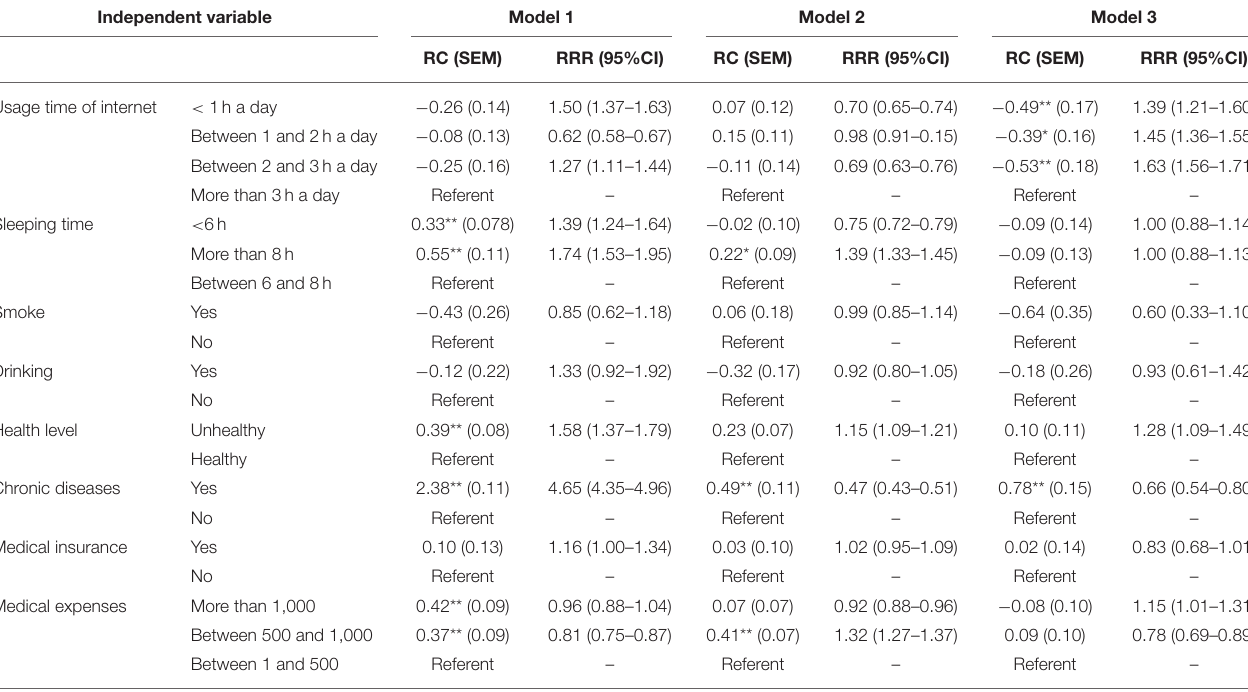
TABLE 4 | Multiple Logistic Regression models of contributing factors of female participation in physical activity (lifestyle and health